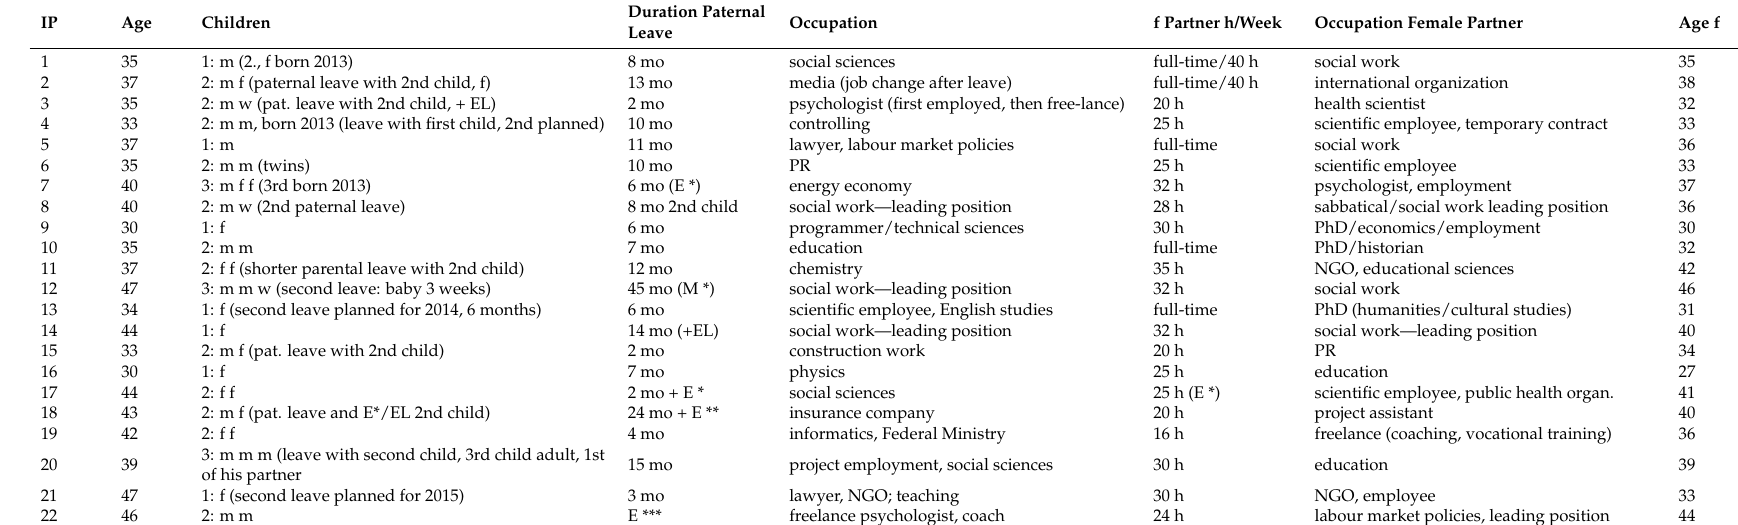
Table 2. Interview partners Project I—childcare allowance models, duration of paternal leave, gainful working hours both